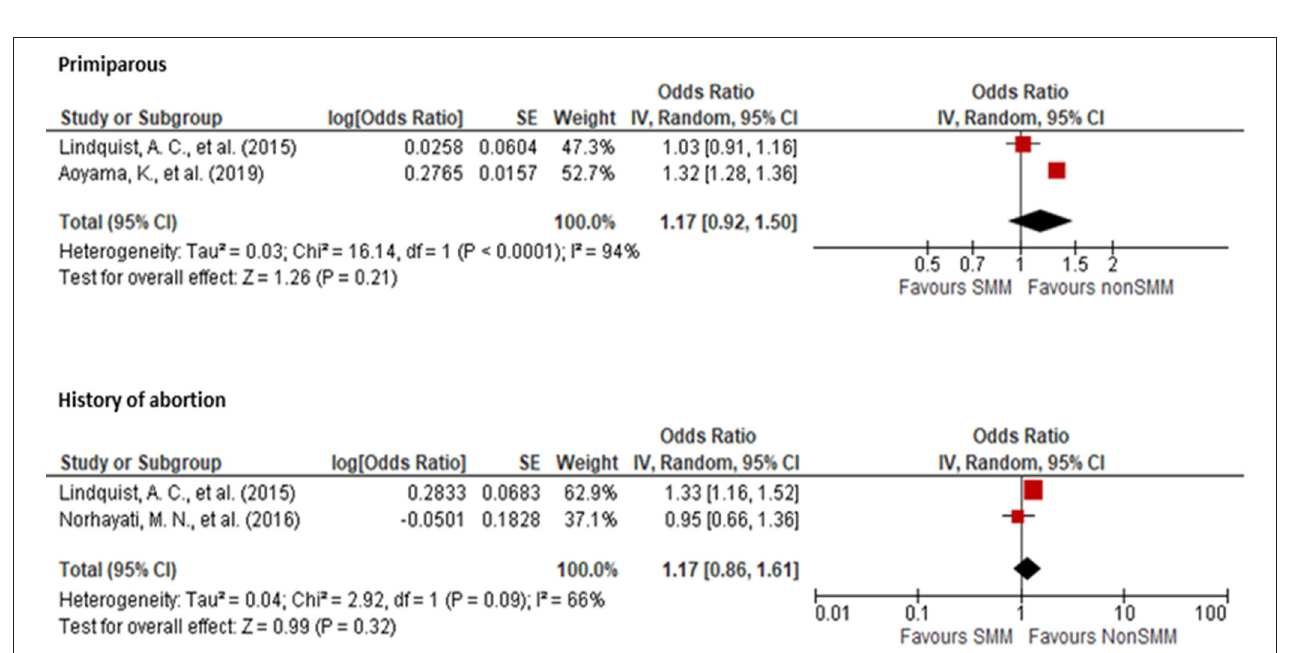
FIGURE 4 | Forest plot showing the association of parity and history of abortion with severe maternal morbidity.